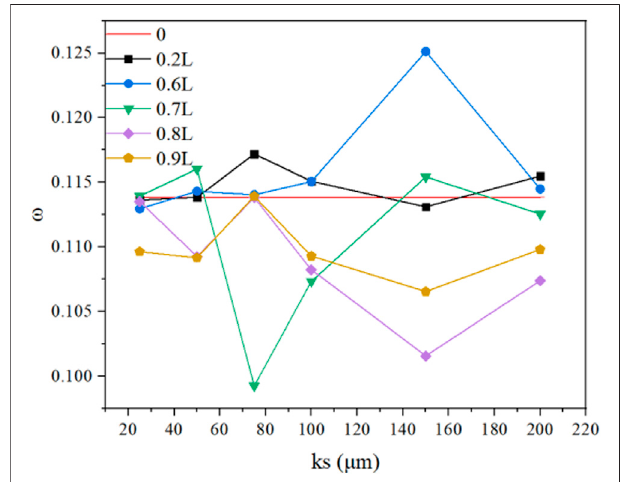
FIGURE 7 | Distribution of surface roughness of the cascade.